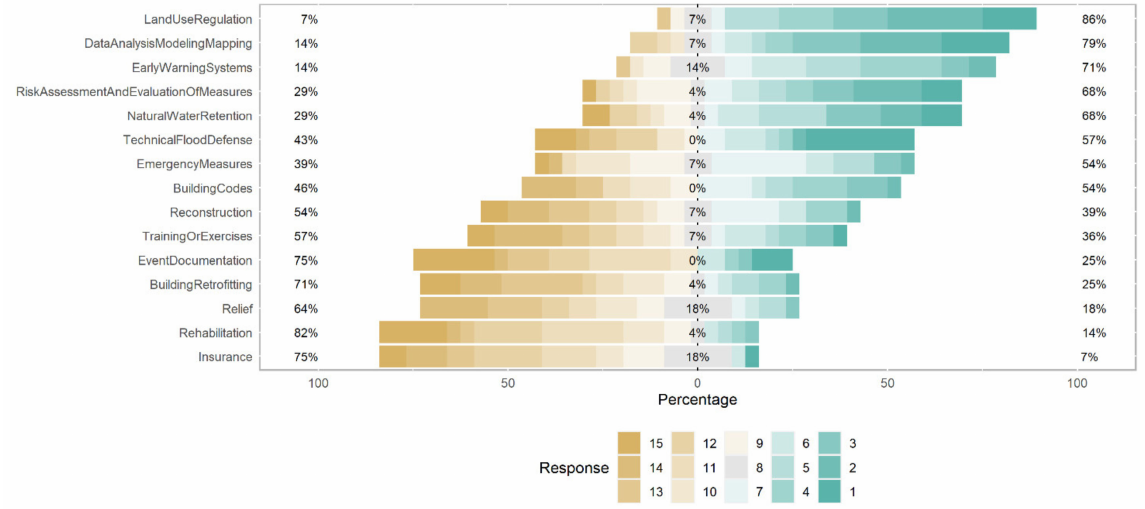
Figure A5. Percentages of Likert Scores for the prioritization of flood measure from early (1) to latest (15) in rural mountain areas.